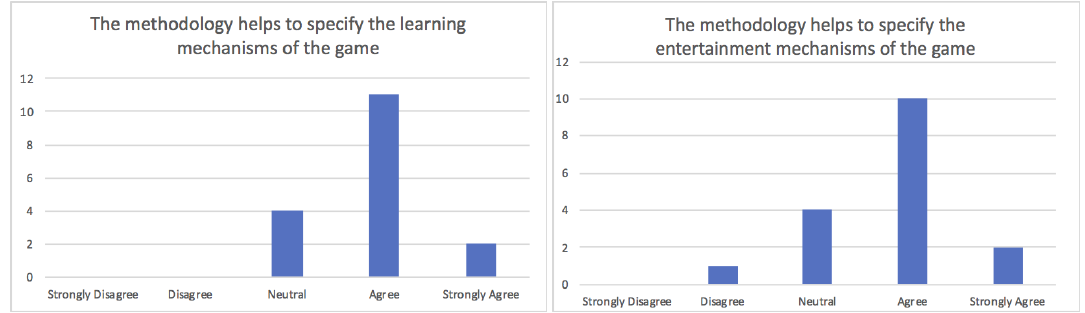
Figure 3. Answer graph about methodology: ( left ) Is it useful in the development of educational games? ( right ) Does it help communication between design-team members?